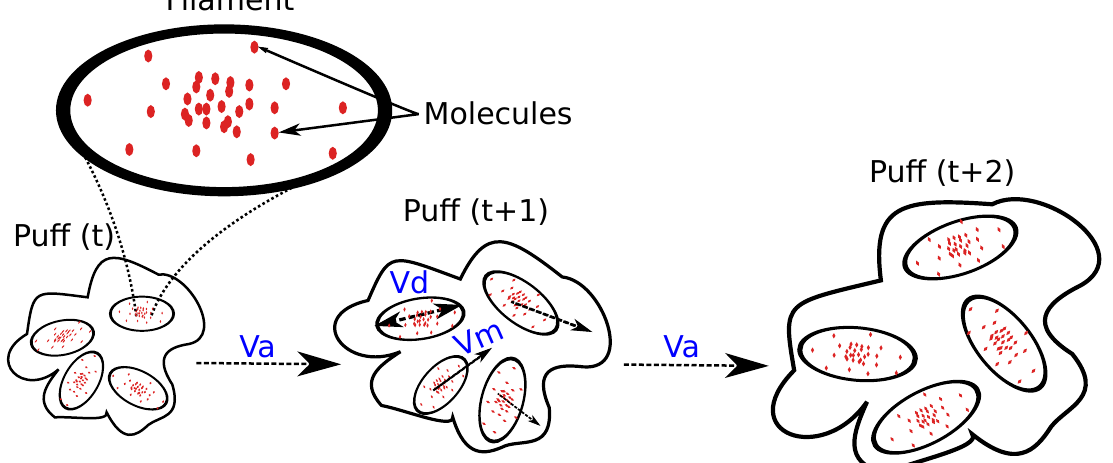
Figure 4. A gas release is modeled as a sequence of puffs, each one composed of multiple filaments (being a filament a 3D Normal distribution of gas molecules). Puffs are affected by advection and diffusion, altering the location of filaments by effect of the wind (v a ) and random processes (v m ), as well as their size (v d ).